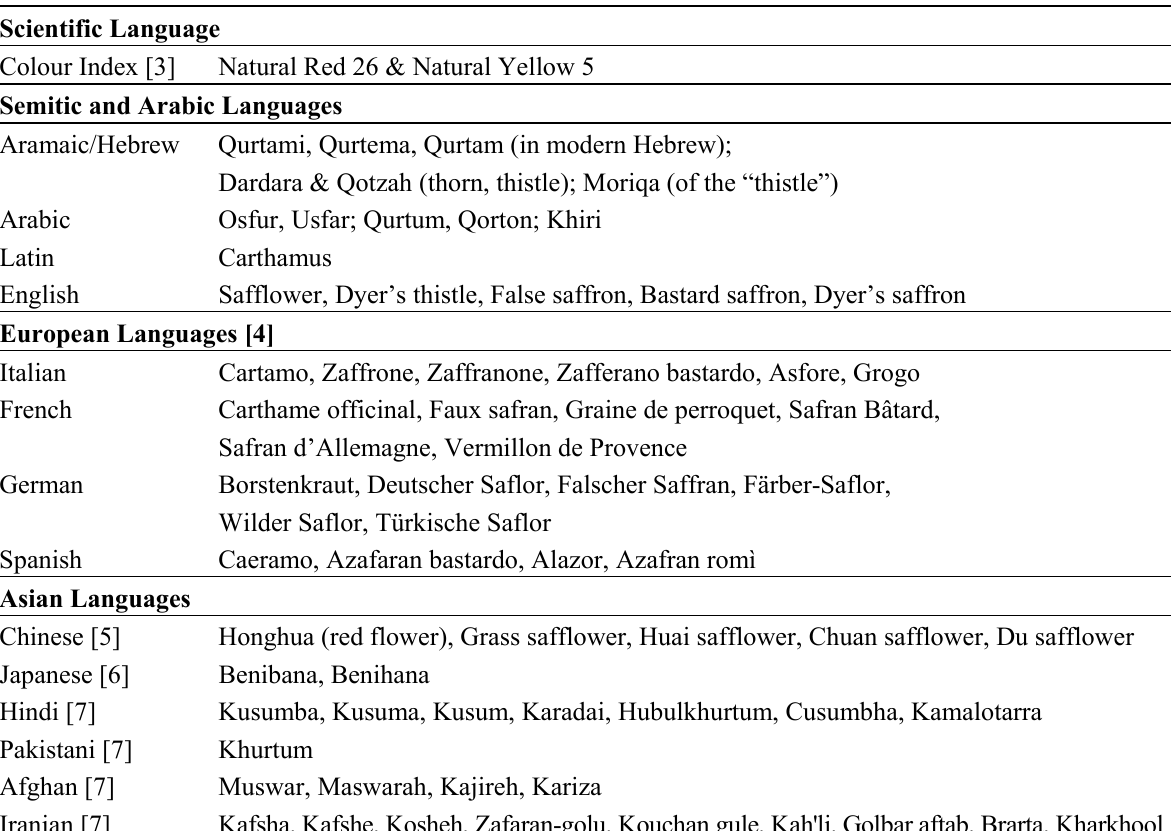
Table 1. Historical and popular names of Carthamus tinctorius in various languages. Scientific Language